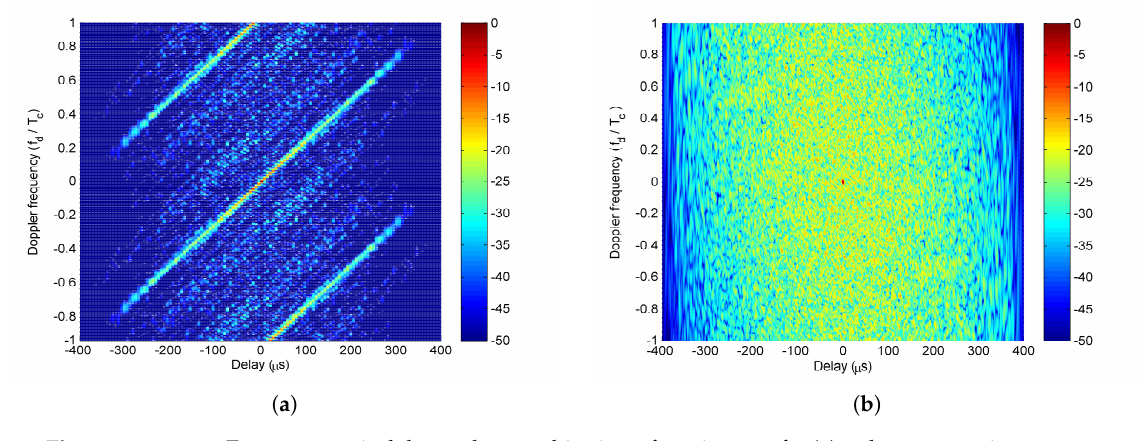
Figure 14. For one-main-lobe, the ambiguity functions of ( a ) the approximate linear-frequency-modulation (LFM) waveforms by sequential iterative algorithm (SIA), ξ = 0.5; ( b ) the optimized LFM-PC